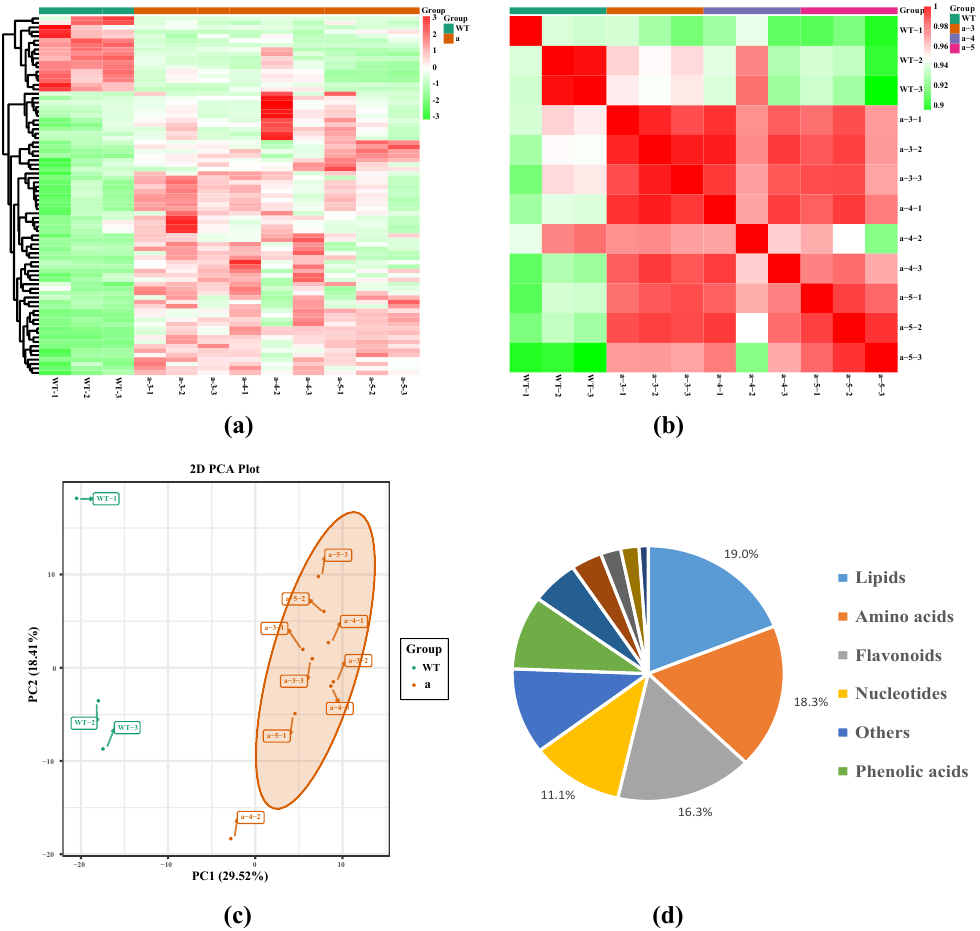
Figure 2. Qualitative and quantitative analysis of the metabolomics data. ( a ) Metabolite clustering heatmap. Abscissa indicates sample name, and ordinate indicates hierarchical clustering results. Red color represents high accumulation, and green color represents low accumulation. ( b ) Pearson’s correlation coe ffi cients among the twelve samples. ( c ) Principal coordinate analysis of the four groups. The abscissa represents the first principal component, and the ordinate represents the second principal component. ( d ) Component analysis of the identified metabolites. The top four metabolites lipids, amino acids, flavonoids, and nucleotides are shown beside the graph. WT represents wild embryogenic cultures; a represents transgenic embryogenic cultures, including WT vs. a-3, WT vs. a-4, and WT vs.